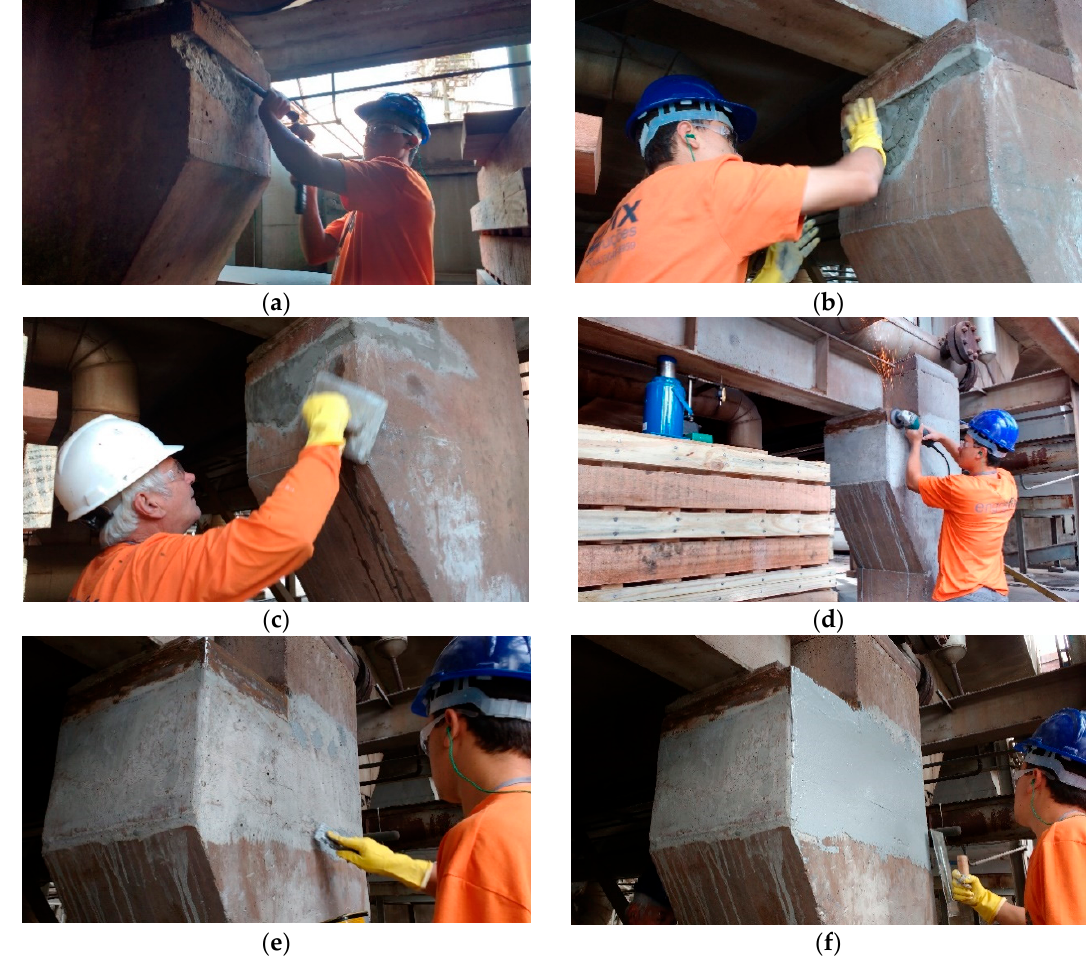
Figure 8. Initial procedures for the damaged corbel: ( a ) manual scarification of the loose concrete, ( b ) application of polymer ‐ modified mortar in the scarified surface; ( c ) straightening of the applied polymeric mortar; ( d ) regularization of the surfaces using a small angle grinder; ( e ) surface holes and voids filled using epoxy resin; and ( f ) standardization of the surfaces using epoxy resin.